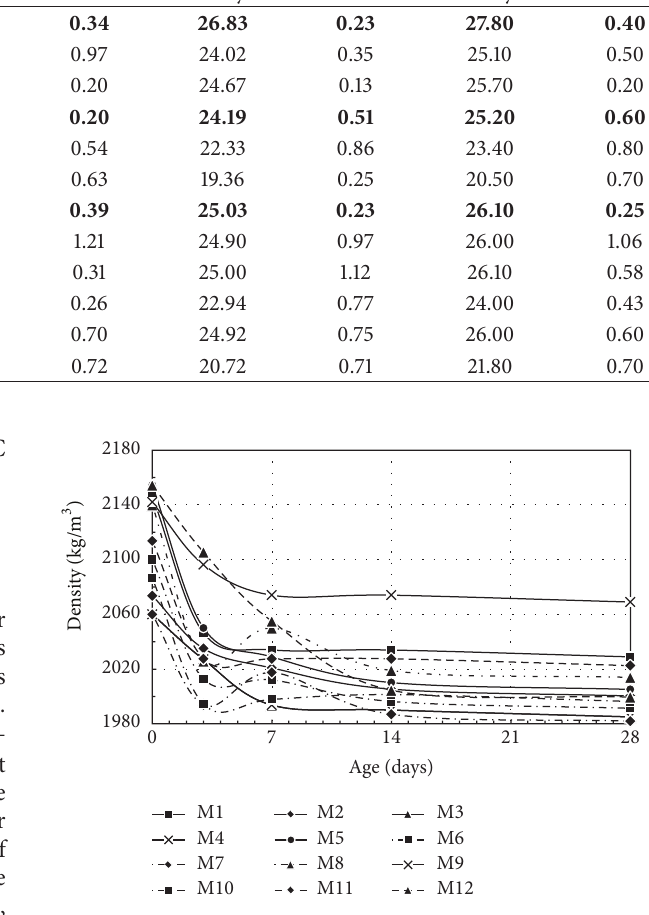
Figure 4: Density versus age